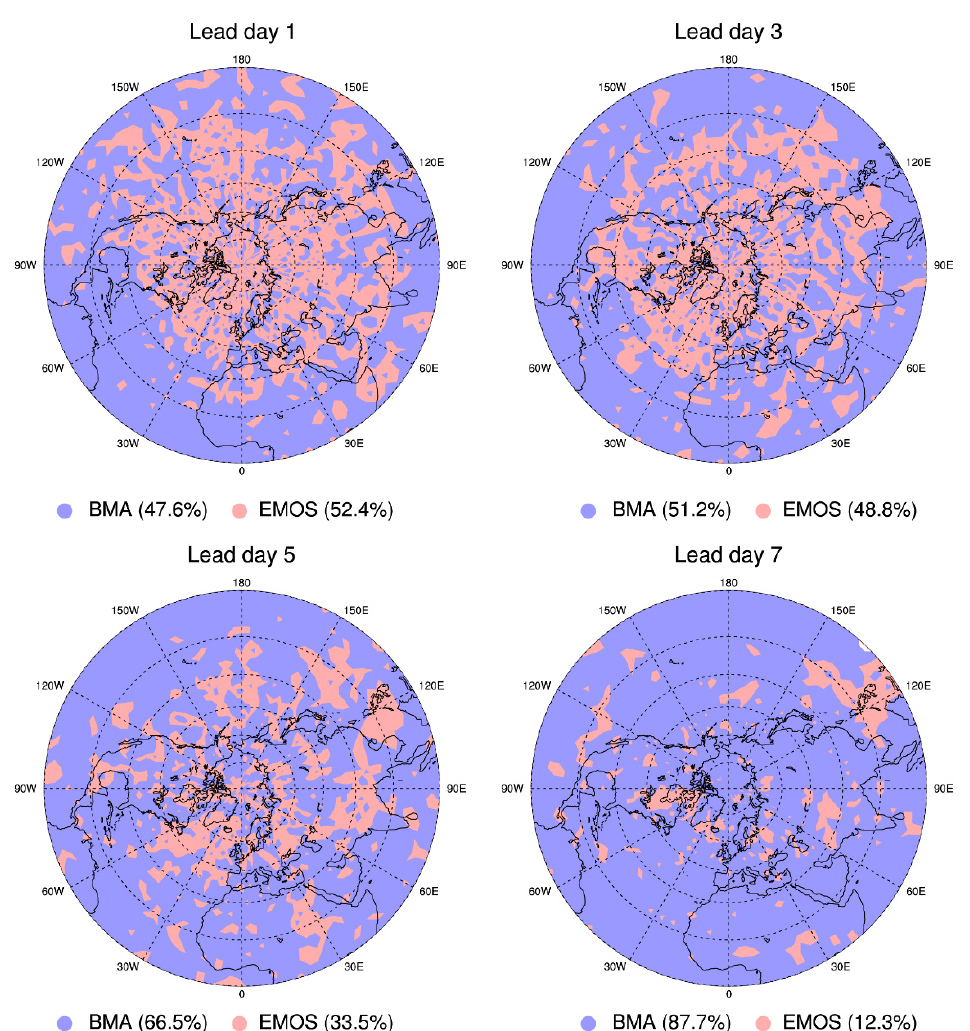
Figure 8. Distribution of the best-performing post-processing methods over the northern hemisphere in terms of the Brier score at different lead times. The percentage of the best-performing post-processing methods is listed under each part.